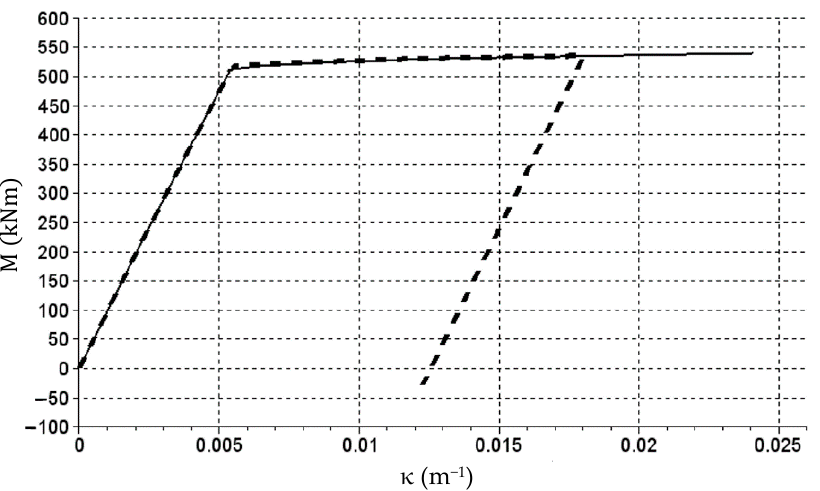
Figure 26. The M(κ) relation graph in cross-sections at beam start and end (thick dashed line) Figure 26. The M ( κ ) relation graph in cross-sections at beam start and end (thick dashed line) overlapped with the graph from Figure 19. overlapped with the graph from Figure